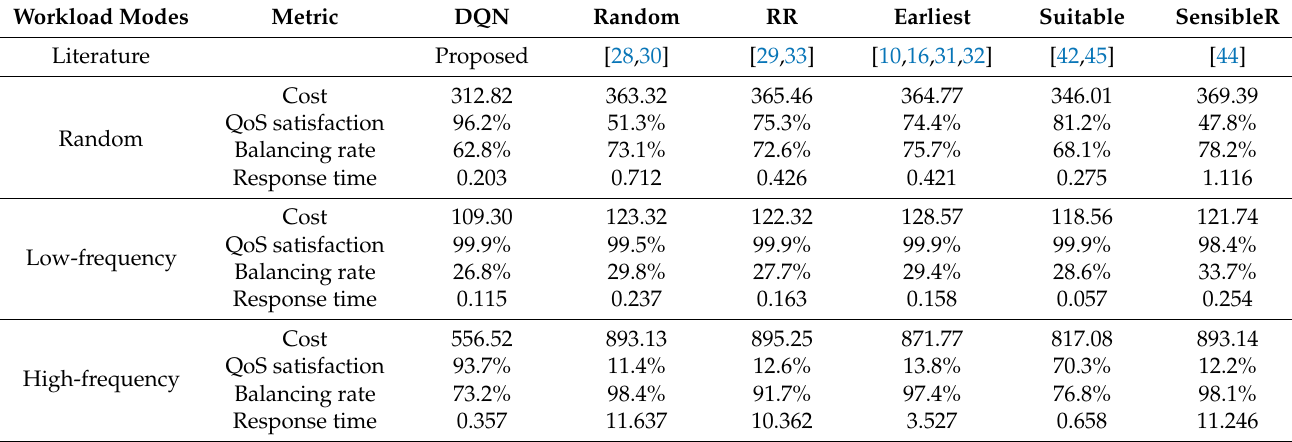
Table 5. Experimental results of the different workload